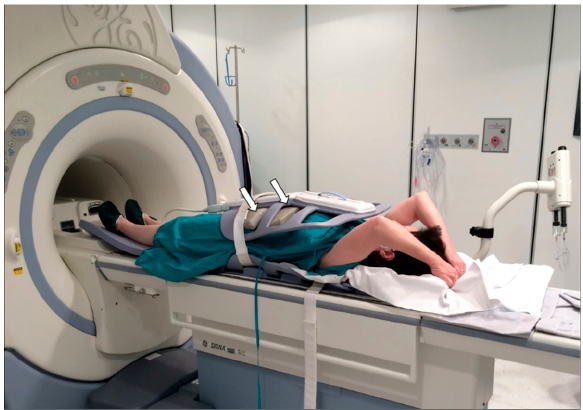
Figure 1. Patient in supine position for dynamic magnetic resonance imaging (MRI) of the breast using a body coil, which is the same as that used for the examination of the abdomen. Note the presence of a pad between the patient’s abdomen and the coil at the level of the strap (arrows). The portion of the coil adjacent to the breast is not hooked to the strap to prevent any possible distortion of the mammary parenchyma during the